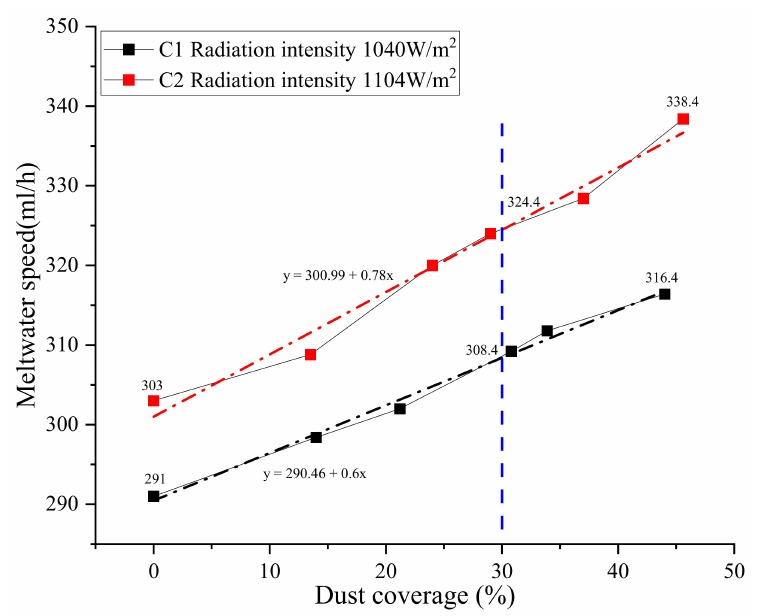
Figure 8. Relationship between the dust coverage rate and meltwater speed (Group